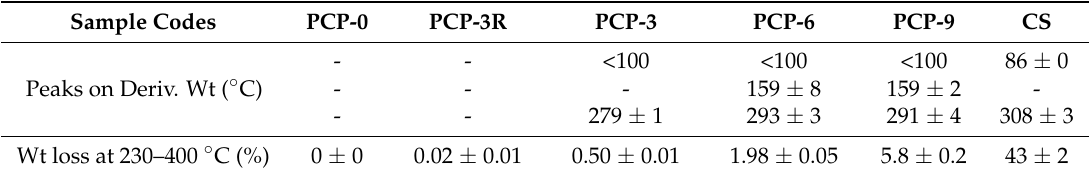
Table 3. Peaks of the Deriv. Wt (the derivative of weight percentage) curves and weight loss in the temperature region of 230–400 ◦ C ( n =